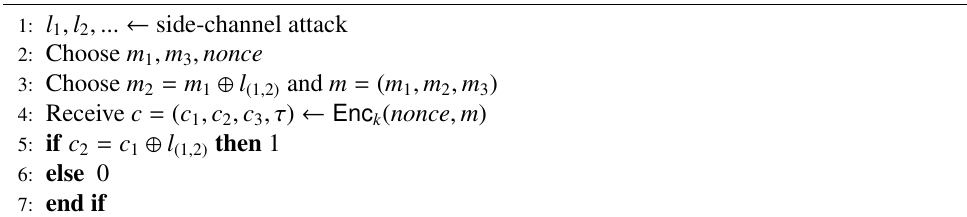
Algorithm 7 Attack against the confidentiality of